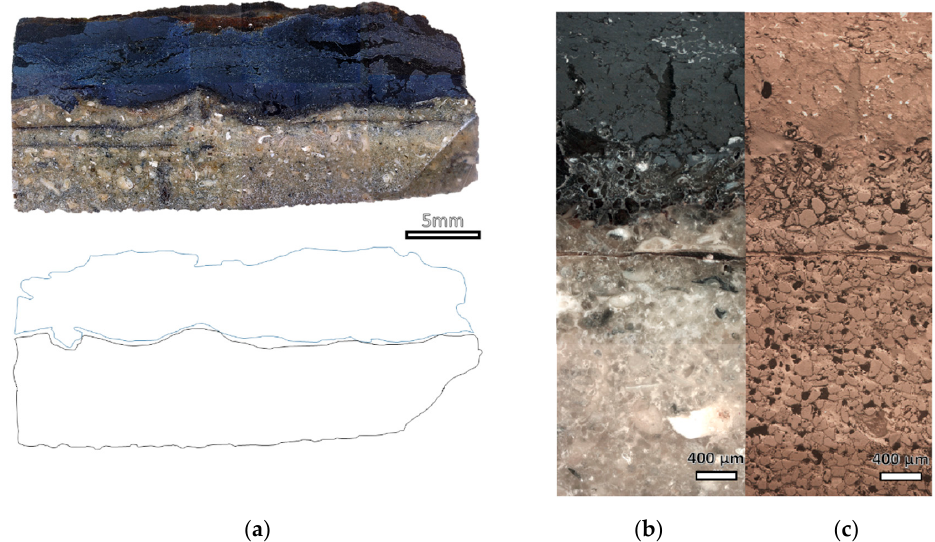
Figure 8. Images acquired from a digital microscope and hand draw scheme of the cross-sections of the lead sheathing ( a ), magnification of the boundary between the two layers at optical microscope under polarised light ( b ) and bright field ( c ).